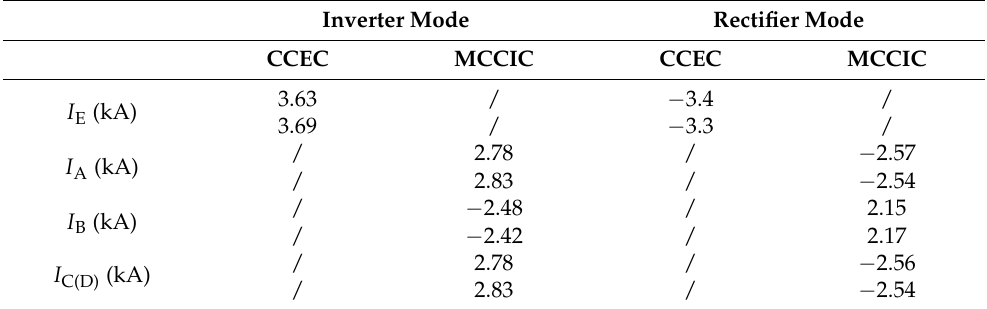
Table 2. Comparisons between the theoretical values and the simulation results of the arm currents.